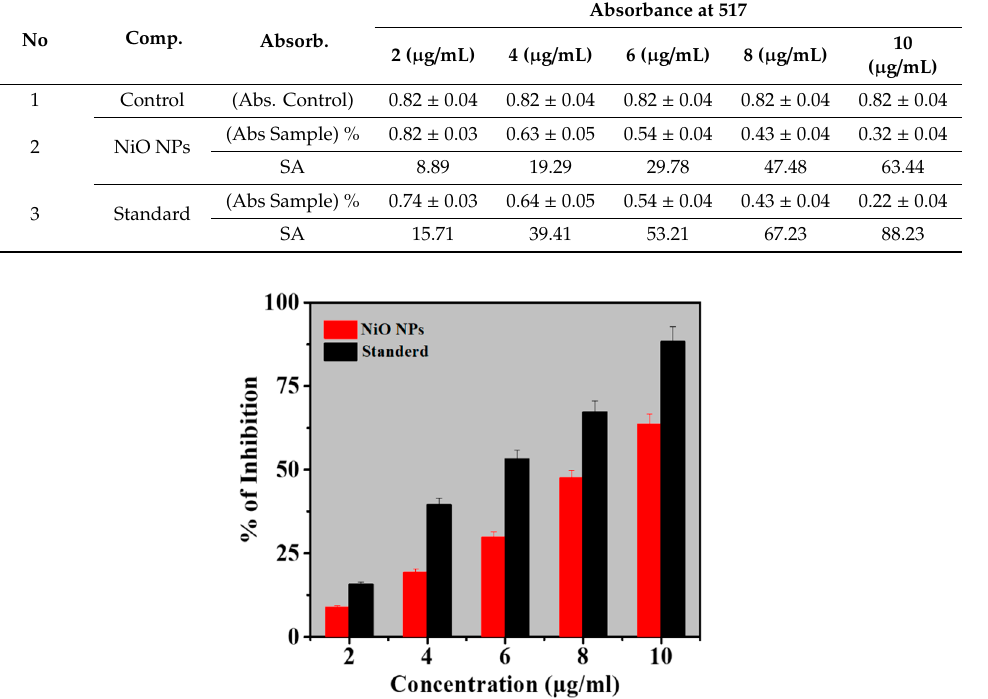
Table 2. Comparative antioxidant activity of NiO NPs and standard L-ascorbic acid (Mean ± SD; n = 3). No Comp.